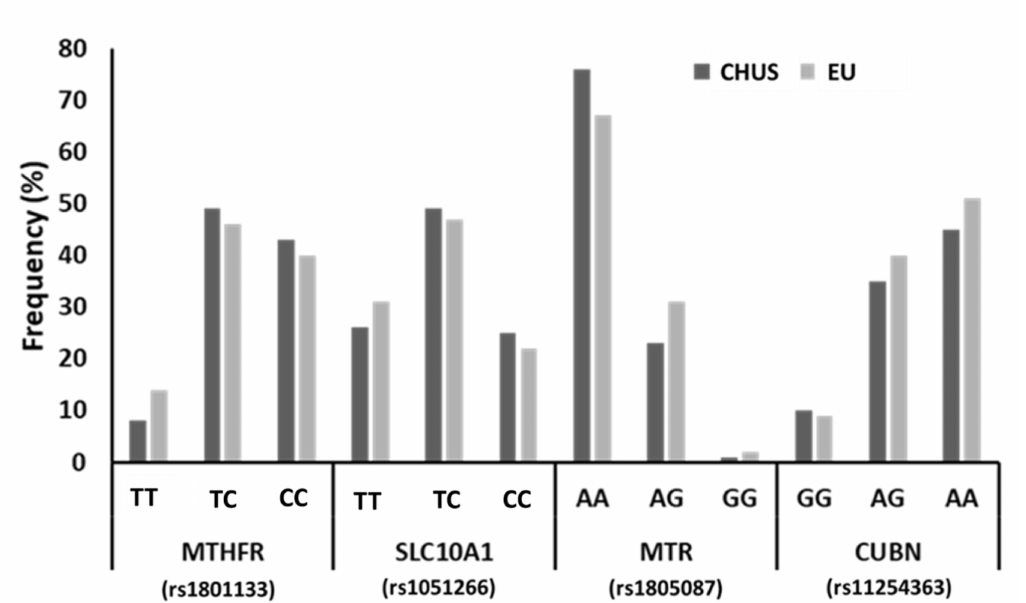
Figure 1. Prevalence of SNP genotypes of genes related to folate and cobalamin metabolism and transport in the study population (CHUS), compared with European population (EU). AA, adenine- adenine genotype; AG, adenine-guanine genotype; GG, guanine-guanine genotype; TT, thymine- thymine genotype; TG, thymine-guanine genotype; CC, cytosine-cytosine genotype; TC, thymine- cytosine genotype; MTHFR, methylenetetrahydrofolate reductase; SLC10A1, reduced folate carrier (RFC1); MTR, methionine synthase; CUBN, cubilin.